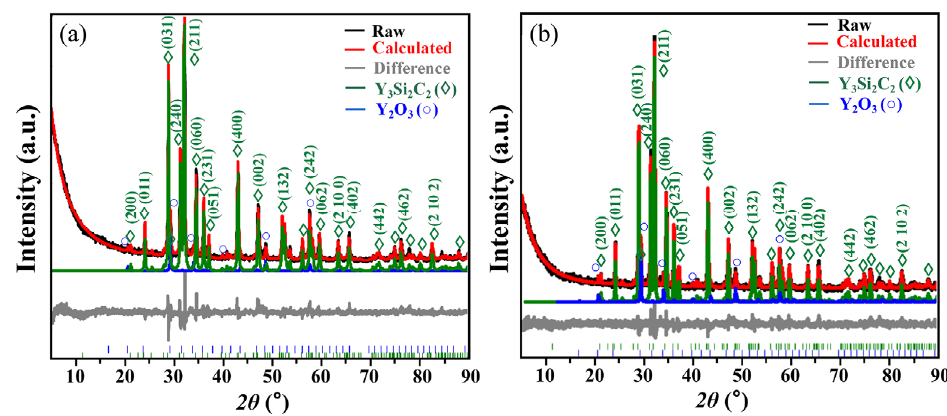
Fig. 2 Rietveld refinement of the XRD patterns of the samples synthesized at 1500 ℃ : (a) bulk and (b) powder. Experimental lattice parameters of Y 3 Si 2 C 2 derived from Rietveld refinement and selected area electron diffraction (SAED) patterns, and their comparison with the calculated and experimental values reported in literature